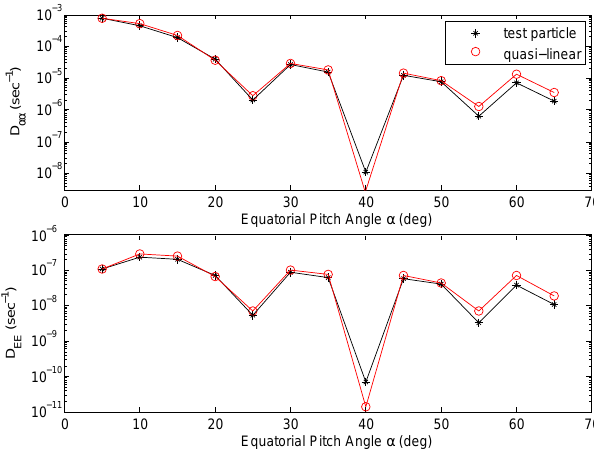
Figure 9. Comparisons of (top) pitch-angle diffusion rates and (bot- tom) momentum diffusion rates obtained from test particle simu- lations (blue curves) and quasi-linear formulation (red curve) for 1Mev electrons at the equator. The wave-normal angle is fixed as 100 ◦ , and the wave frequencies vary with initial electron pitch angle to satisfy the N = 1 resonance condition at the equator.